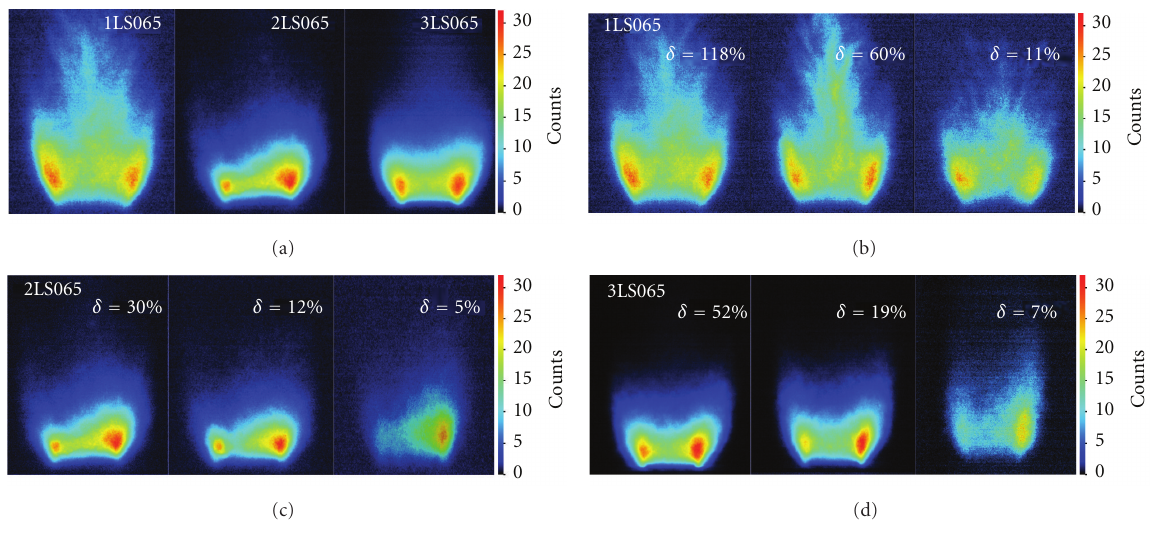
Figure 6: OH ∗ flame chemiluminescence images for the three burner set ups at various fuel injection levels (where δ denotes proximity to LBO, Table 1) and a swirl intensity of 0.65.